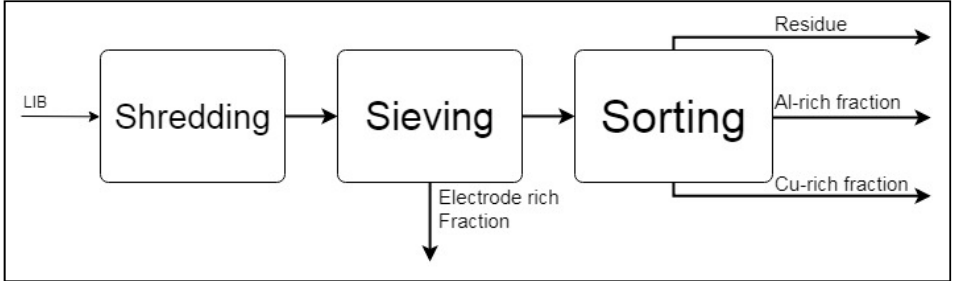
Figure 3. Flowsheet of the proposed process based on the results obtained by [20]. LIB: Lithium-ion battery.